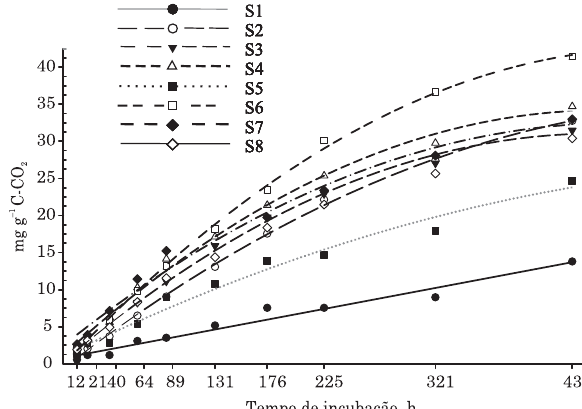
Figura 3. Respiração acumulada (mg g -1 de C-CO C do substrato seco) ao longo do período de in- cubação de serapilheira, solo e diferentes com- binações serapilheira/solo de Pinus elliottii